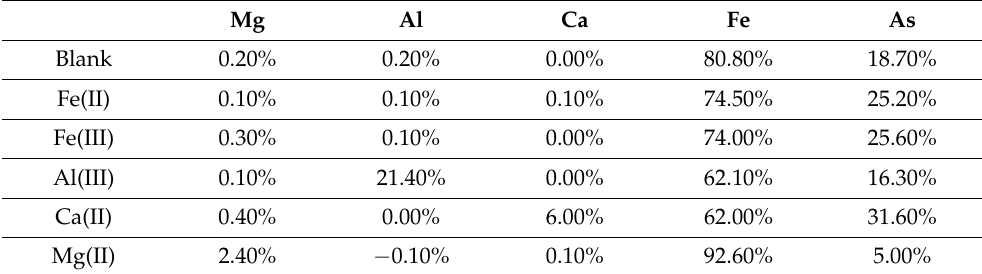
Table 2. SEM-EDS analysis of elements in precipitates.